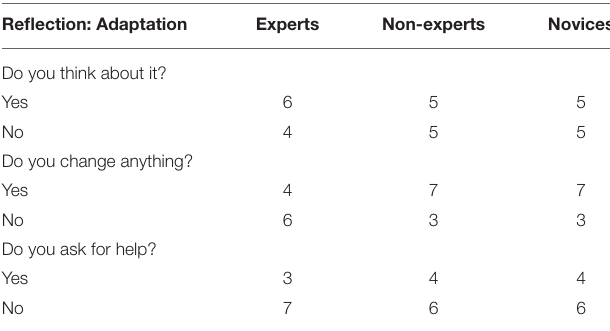
TABLE 5 | An overview of how different strategies were used across the three skill levels at both question times.